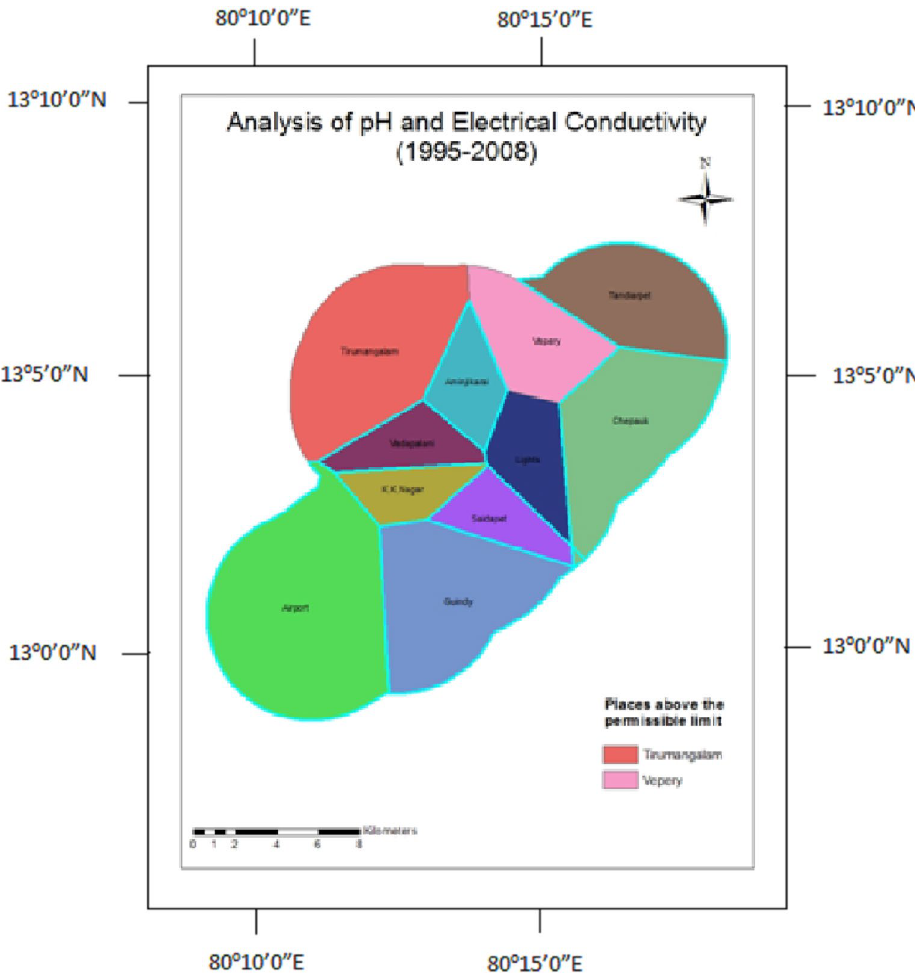
Figure 9. Analysis of pH and electrical conductivity for